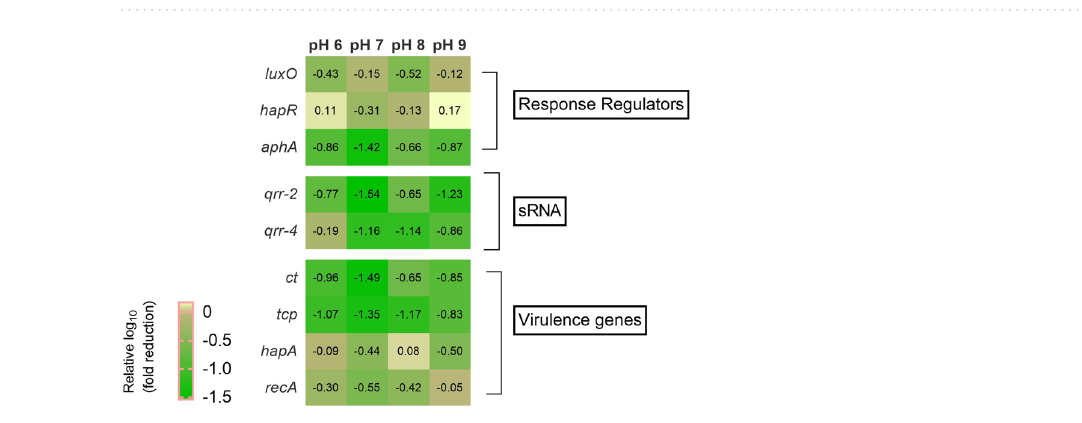
Figure 12. Heat map representation of the relative log 10 -fold downregulation of the expression of genes encoding quorum sensing response regulators, cholera toxin, and toxin co-regulated pili in V. cholerae MTCC 3905 by CAP-2M4VP at pH 6, pH 7, pH 8, and pH